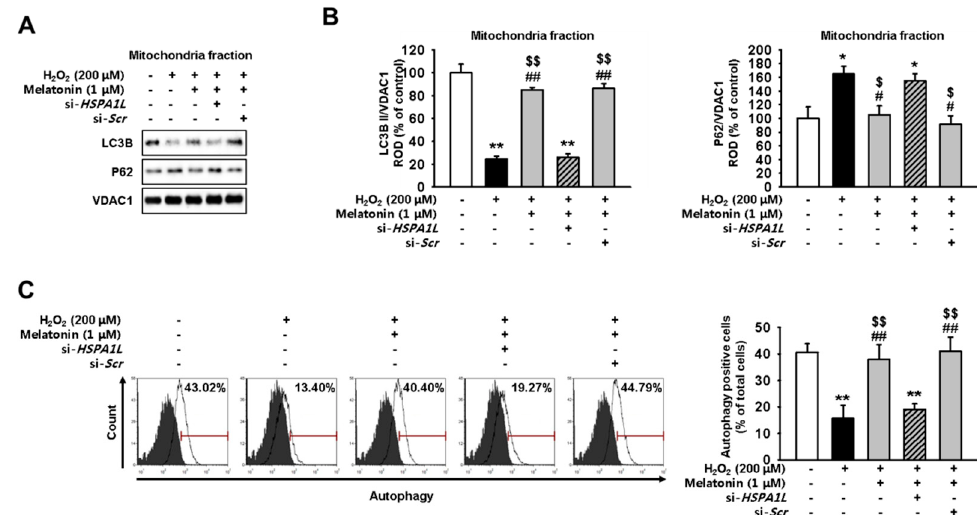
Figure 3. Treatment with melatonin enhances mitophagy by stabilizing parkin in hMSCs subjected to oxidative stress. ( A ) Expression of P62 and LC3B II in mitochondrial fractions obtained from melatonin-treated (1 µ M, 24 h) hMSCs, si- HSPA1L -treated hMSCs, and untreated control hMSCs; all cell groups were subjected to oxidative stress. ( B ) Expression levels were normalized relative to those of VDAC1. Values represent the mean ± SEM. * p < 0.05, and ** p < 0.01 vs. untreated hMSCs; # p < 0.05, and ## p < 0.01 vs. H 2 O 2 -treated hMSCs; $ p < 0.05, and $$ p < 0.01 vs. melatonin-treated hMSCs pretreated with si- HSPA1L . ( C ) hMSCs treated with melatonin (1 µ M, 24 h) and si- HSPA1L were quantified as autophagy-positive or autophagy-negative using FACS. Values represent the mean ± SEM. ** p < 0.01 vs. untreated hMSCs; ## p < 0.01 vs. melatonin-treated hMSCs; $$ p < 0.01 vs. melatonin-treated hMSCs pretreated with si- HSPA1L .